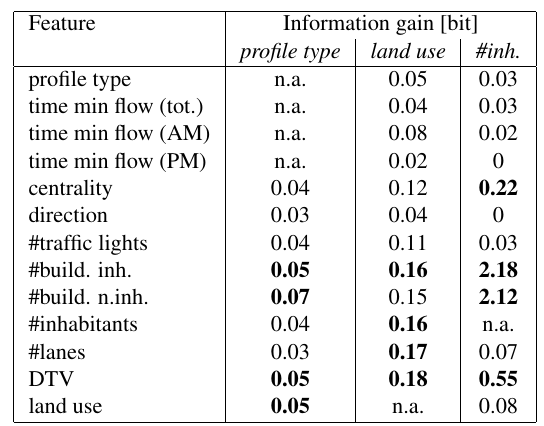
Table 2. The information gain of the features in relation to the corresponding classification task. Not evaluated features are marked by